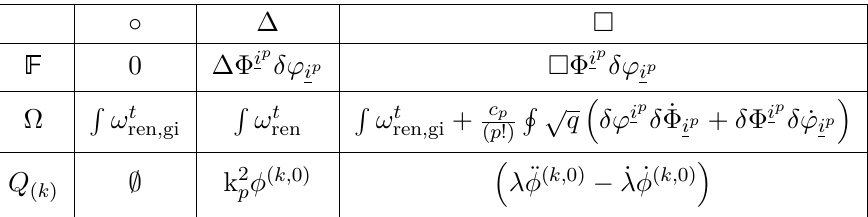
Table 2 . This table summarizes our main results. F is the flux. Φ i p is the exact part of the tangent “magnetic field” F . ϕ i p is the gauge mode and φ ( k, 0) is the gauge invariant p component defined ri p +1 in (2.19). ∆ and (cid:3) are also the Laplacian operators respectively on the sphere and on the cylinder. Q is the surface charge smeared on p -form spherical ( k )